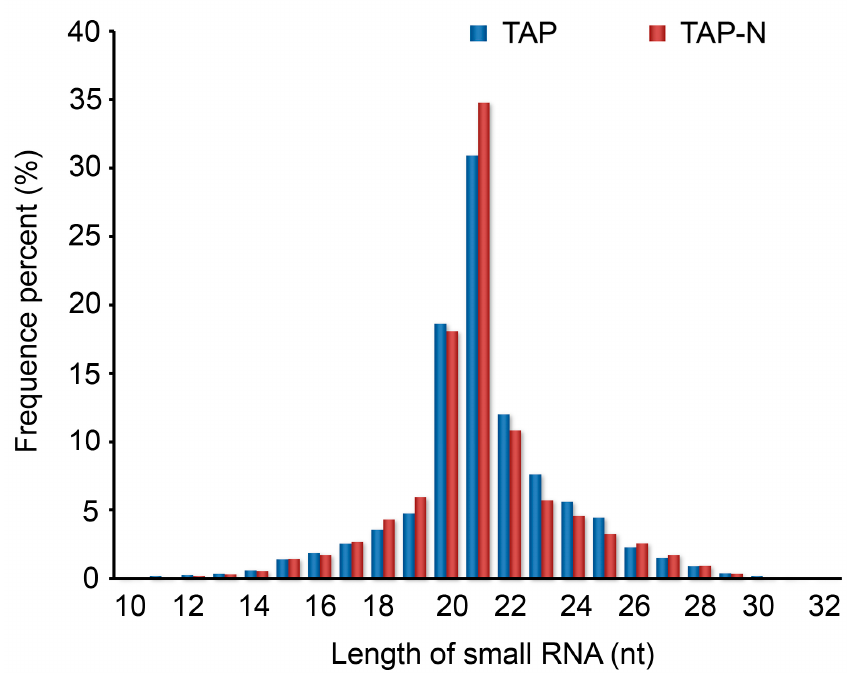
Figure 2. The length size distributions of small RNAs from the libraries of both TAP and TAP-N. The occurrences of each unique sequence read were counted to reflect relative expression level, and only small RNA sequences in the range of 10 to 32 nt were considered. TAP represents unique sequence reads of small RNAs of C. reinhardtii cultivated in nitrogen-replete medium; TAP-N represents unique sequence reads of small RNAs of C. reinhardtii cultivated in nitrogen deficiency medium.